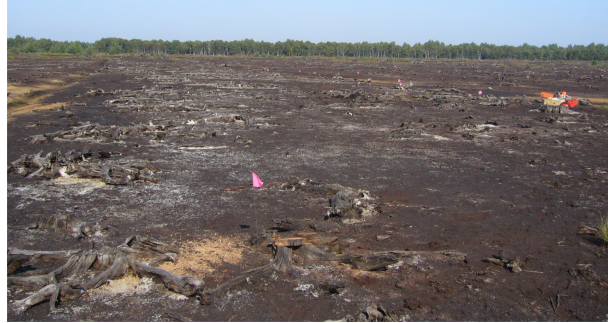
Figure 2. View of site TOMO_south. The upper layers of peat have been removed. Numerous tree stumps are protruding. Photo: Inke